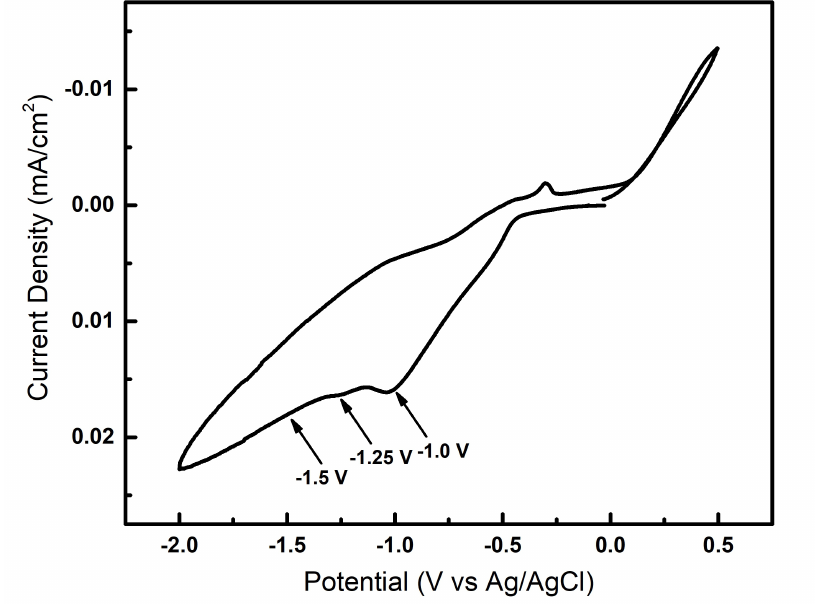
Figure 1. Results from cyclic voltammogram showing variation of current with positive (oxidizing) potentials and negative (reducing) potentials. Increasing the negative potential beyond hydrogen